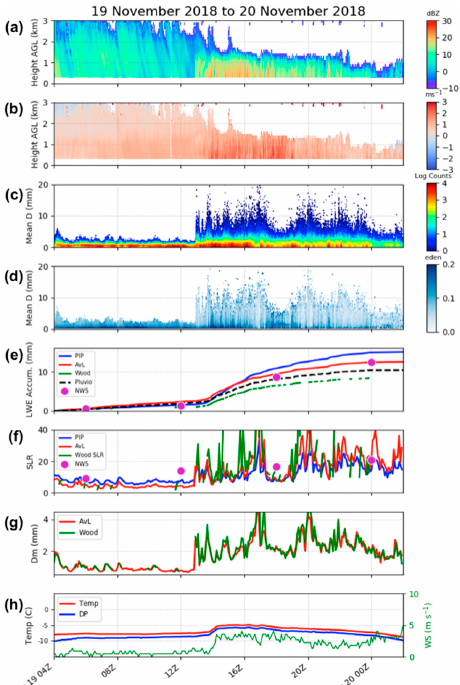
Figure 10. Example of a snow event that transitions from low to high SLR snowfall from 19 to 20 November 2018. ( a ) Shown is data from the MRR reflectivity, ( b ) MRR Doppler velocity, ( c ) PIP-produced PSDs, ( d ) PIP-derived ρ e distribution as a function of D e , liquid water equivalent (LWE) accumulation for all three retrievals, ( e ) the Pluvio, and the NWS 6-hourly snow field, ( f ) calculated SLR from all three retrievals and the NWS 6-hourly snow field observations, ( g ) the mass-weighted diameter ( D m ) from von Lerber and Wood, ( h ) and the surface meteorological conditions. All variables are presented as a function of time from 19 November at 0400 UTC to 20 November at 0200 UTC. The transition from low to high SLR occurs at approximately 1300